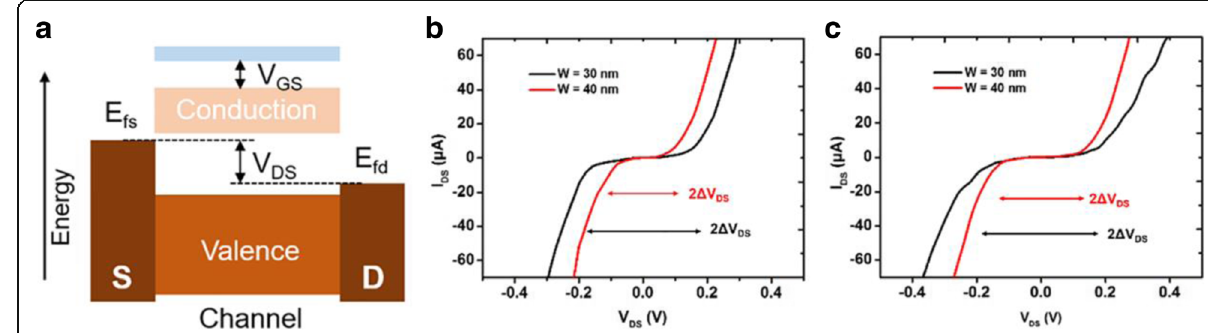
Fig. 5 a Schematic energy band diagram for a GNR with source and drain electrodes. Curves of I DS versus V DS at a V GS bias near the charge neutral voltage for b r-GNM and c